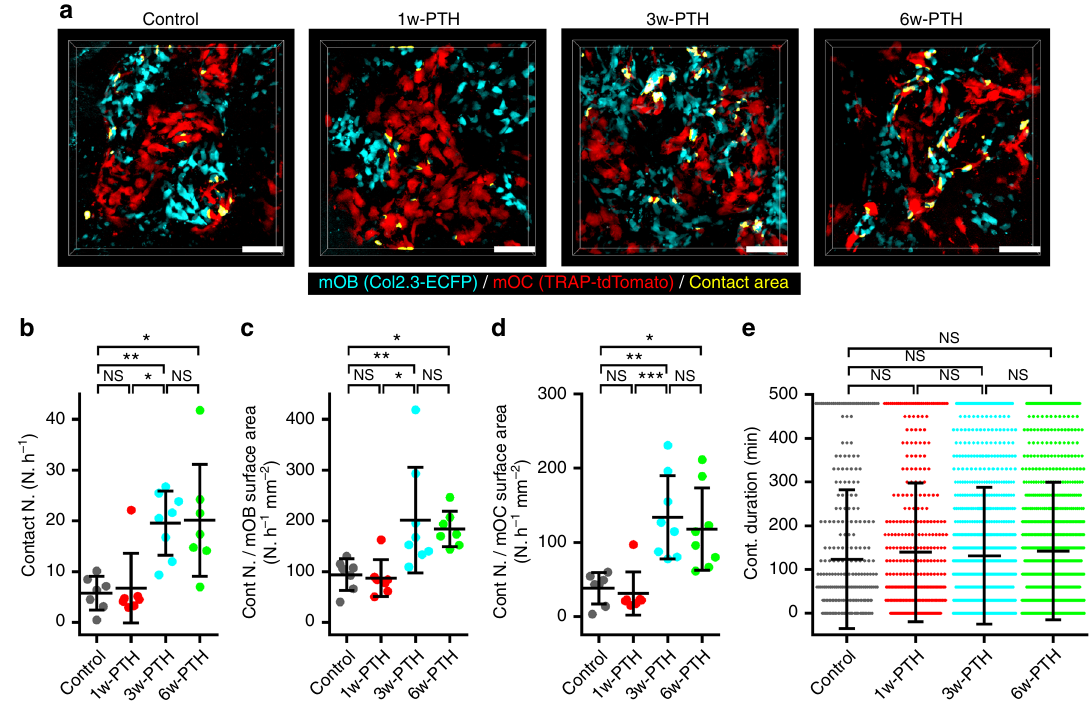
Fig. 5 Intermittent PTH treatment increases the number of contact. a 3D colocalization analysis of representative images from control mice and 1-w-, 3-w-, and 6-w-PTH-treated Col2.3-ECFP/TRAP-tdTomato mice. Cyan, mOBs expressing Col2.3-ECFP; red, mOCs expressing TRAP-tdTomato. The contact areas were de fi ned as the areas of colocalization of mOBs and mOCs, and are shown in yellow. Scale bar, 100 µ m. b The number of mOB – mOC contacts. The duration of a mOB – mOC contact event was de fi ned as the time from initial attachment to the end of mOB – mOC contact. c The numbers of contact events normalized by the surface areas of the mOBs. d The numbers of contact events normalized by the surface areas of the mOCs. b – d The data were collected from seven to eight independent experiments per group (control; n = 7, 1-w-PTH; n = 7, 3-w-PTH; n = 8, 6-w-PTH; n = 7). e The duration of mOB – mOC contact. Data were collected in seven to eight independent experiments performed per group (control; n = 322, 1-w-PTH; n = 375, 3-w-PTH; n = 1,252, 6-w- PTH; n = 1,126). Data are presented as means ± SDs. * p < 0.05; ** p < 0.01; *** p < 0.001; NS, not signi fi cant (Kruskal – Wallis